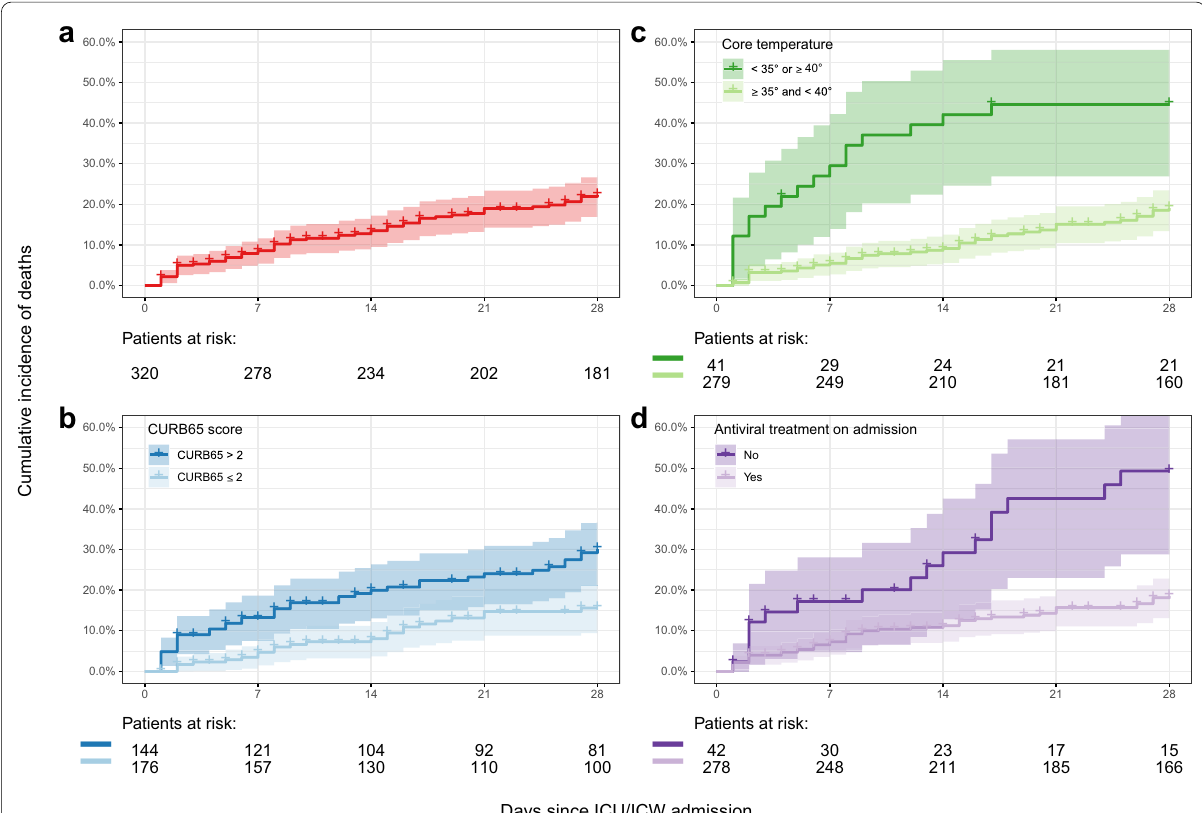
Fig. 2 Cumulative incidence of deaths following ICU/ICW admission, overall ( a ), and according to the CURB65 score ( b ), core temperature ( c ) and antiviral treatment on admission ( d ).Panels illustrate the combination of the independant factors associated with 28-day mortality (second model), including the class of CURB65 (which may be either > 2 or 2; panel a ), the core temperature on ICU admission (which may be either < 35 °C or ≤ 40 °C, or 35 °C and < 40 °C; panel c ), and the antiviral treatment administered on ICU admission (panel d ≥